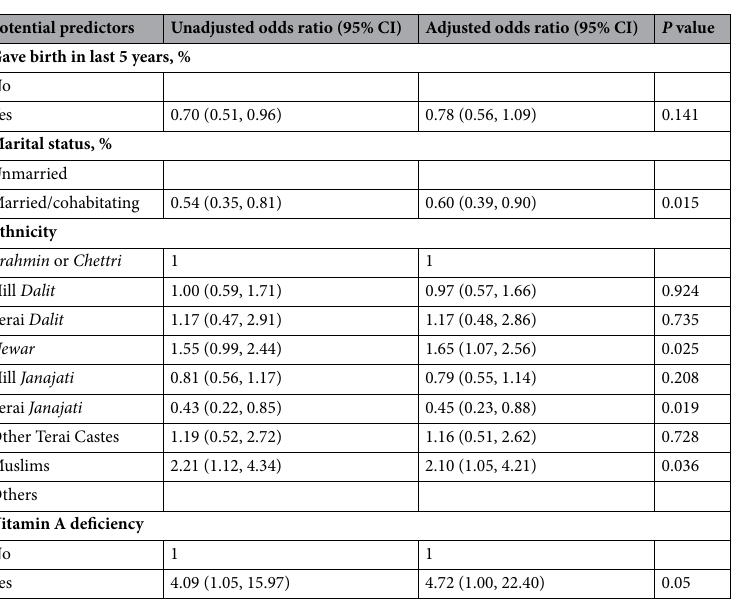
Table 5. Predictors of soil transmitted helminths among non-pregnant women aged 15–49 years, Nepal National Micronutrient Status Survey, Nepal, 2016. Estimates are unadjusted odds ratios and adjusted odds ratios with 95% confidence intervals from logistic regression models, accounting for weighting and complex sampling design. Vitamin A deficiency was defined as RBP < 0.64 μmol/L 28 .